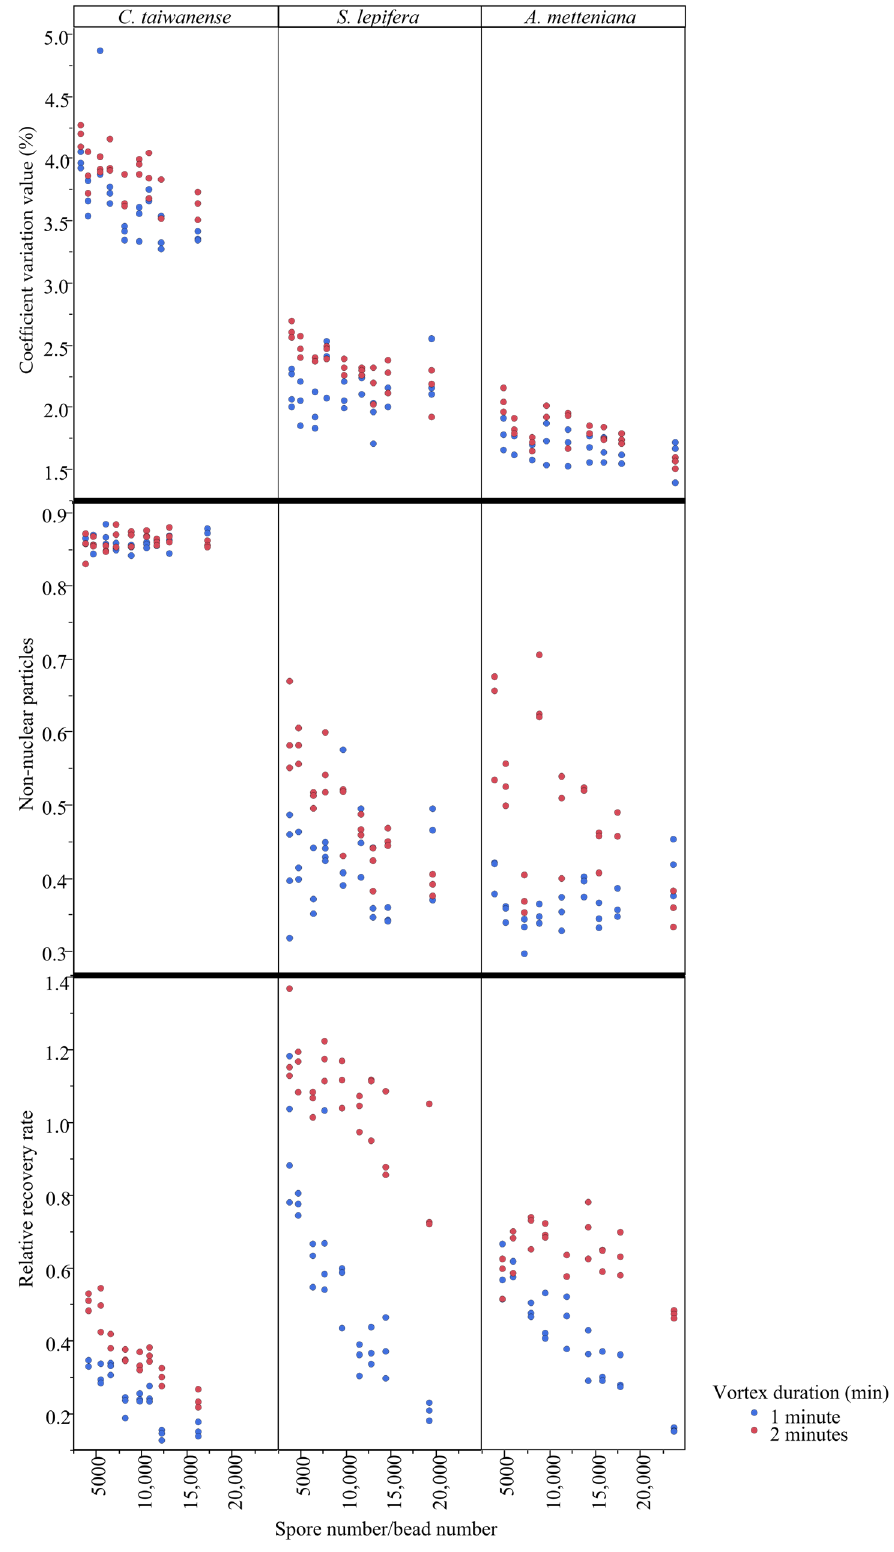
Figure 2. Coefficient variation (CV) value, non-nuclear particles ( np ), and relative recovery rate ( rrr ) of the three spore collections among vortex duration and spore–bead ratios.